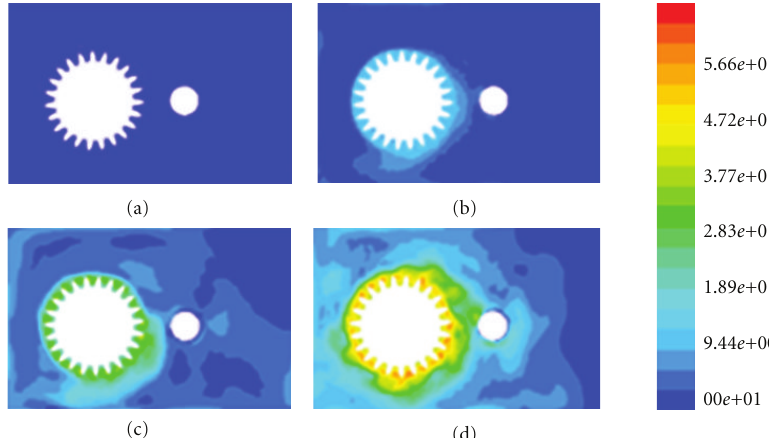
Figure 7: Contour plot of the velocity field for four di ff erent tangential velocities (m/s) in the symmetry plane of the gear: (a) 500rpm; (b) 2000 rpm; (c) 5000 rpm; (d) 8000 rpm.